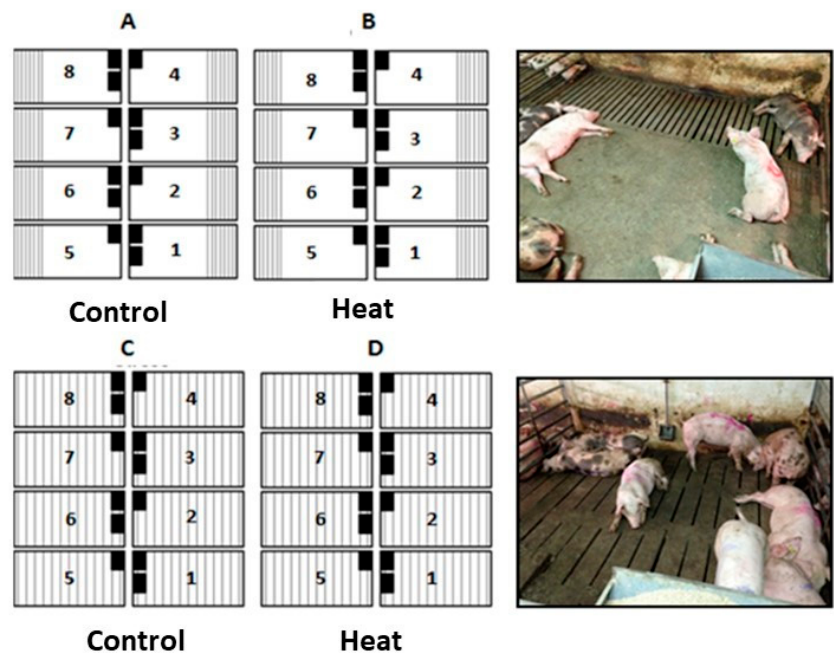
Figure 2. Scheme of the experimental design, considering the combination of two environmental temperatures (control and heat), type of floor (30% or 100% slat), and number of feeders (one or two). Room A had a 30% slatted floor, combined with a heat treatment; Room B, a 30% slatted floor with control temperature; Room C, 100% slatted floor with heat, and Room D, 100% slatted with control temperatures. All pens had eight animals inside, four females and four (vaccinated with Improvac ® ), and vaccinated with Improvac ® and the same number of pens with one or two feeders inside.